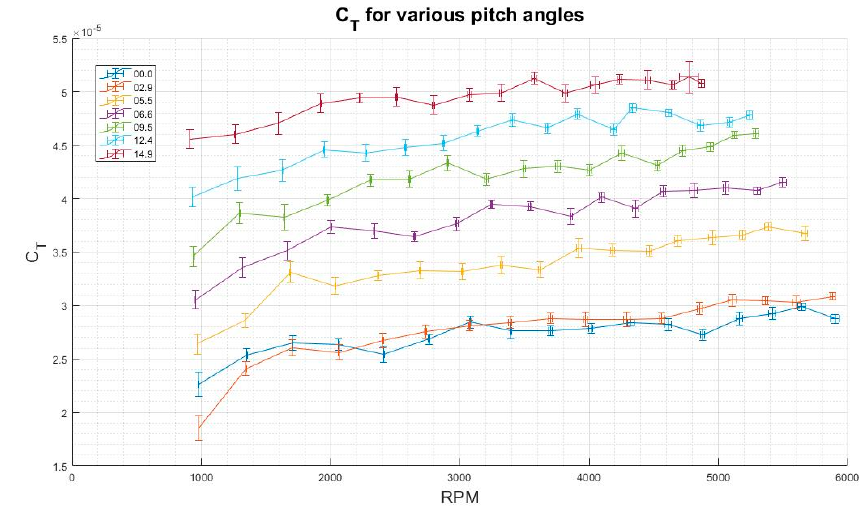
Figure 7. Coe ffi cient of thrust ( C T ) for various pitch Figure 7. Coefficient of thrust ( C T ) for various pitch angles. Figure 7. Coefficient of thrust ( C T ) for various pitch angles.